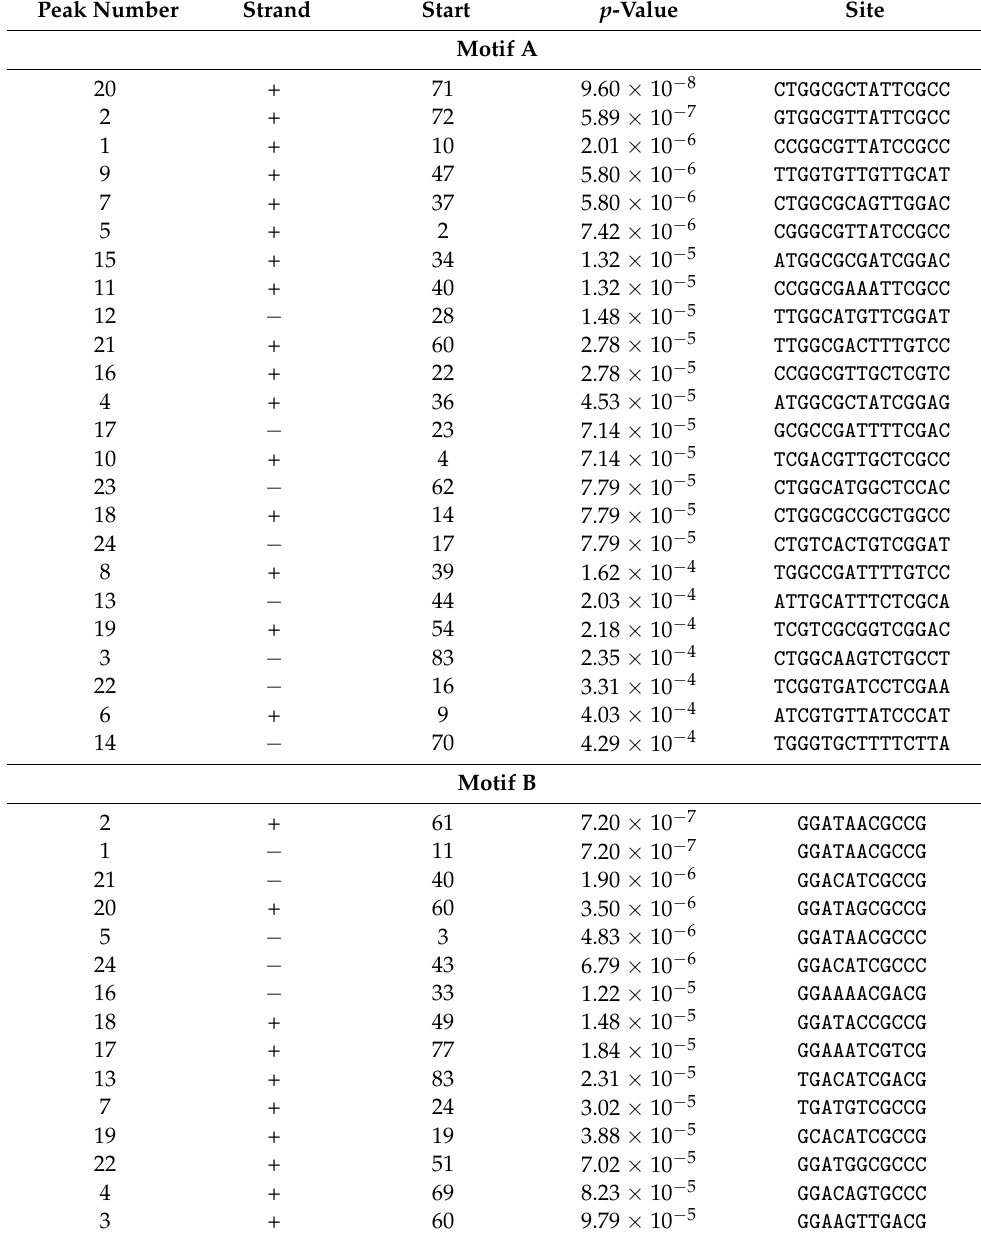
Table A1. PA3027 DNA binding motifs in ChIP-seq peaks. The DNA binding motifs were identified using MEME-ChIP version 5.3.0 [44,45] and DNA corresponding to 200 bp around 24 summits of ChIP-seq peaks (Supplementary Text S1). Motif A was identified with the settings, allowing one occurrence per sequence, whereas motif B was searched using a setting allowing zero or one occurrence per